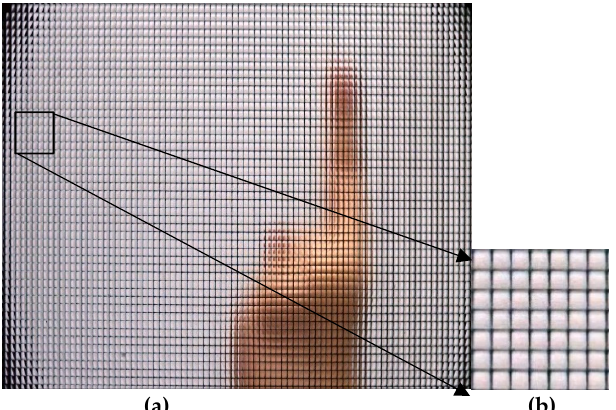
Figure 4. ( a ) The Holoscopic 3D micro gesture image contains of multiple 2D element Images. ( b ) The feature extraction for the Holoscopic 3D Image is extracting pixels from each lens to form a segment, the segment will form part of the image.